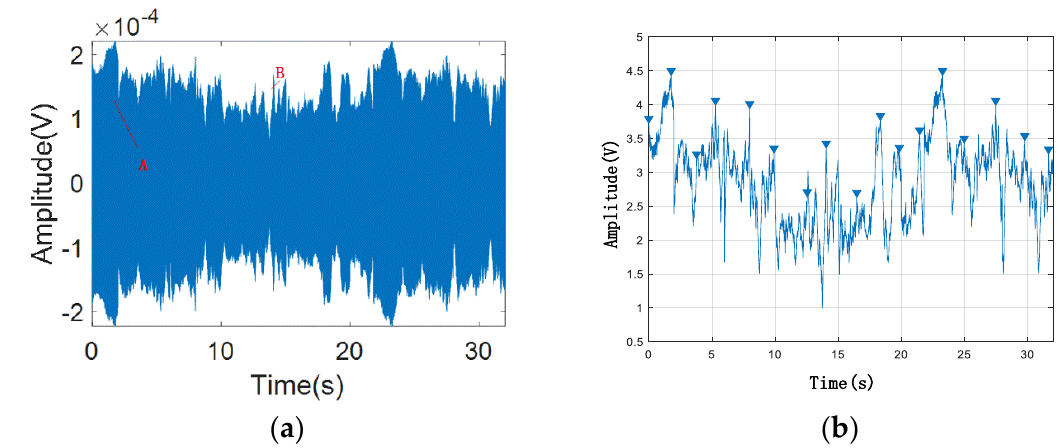
Figure 17. The output of the received signal with directional antennas on a bumpy road: ( a ) the raw received signal; ( b ) the envelope of the received signal.